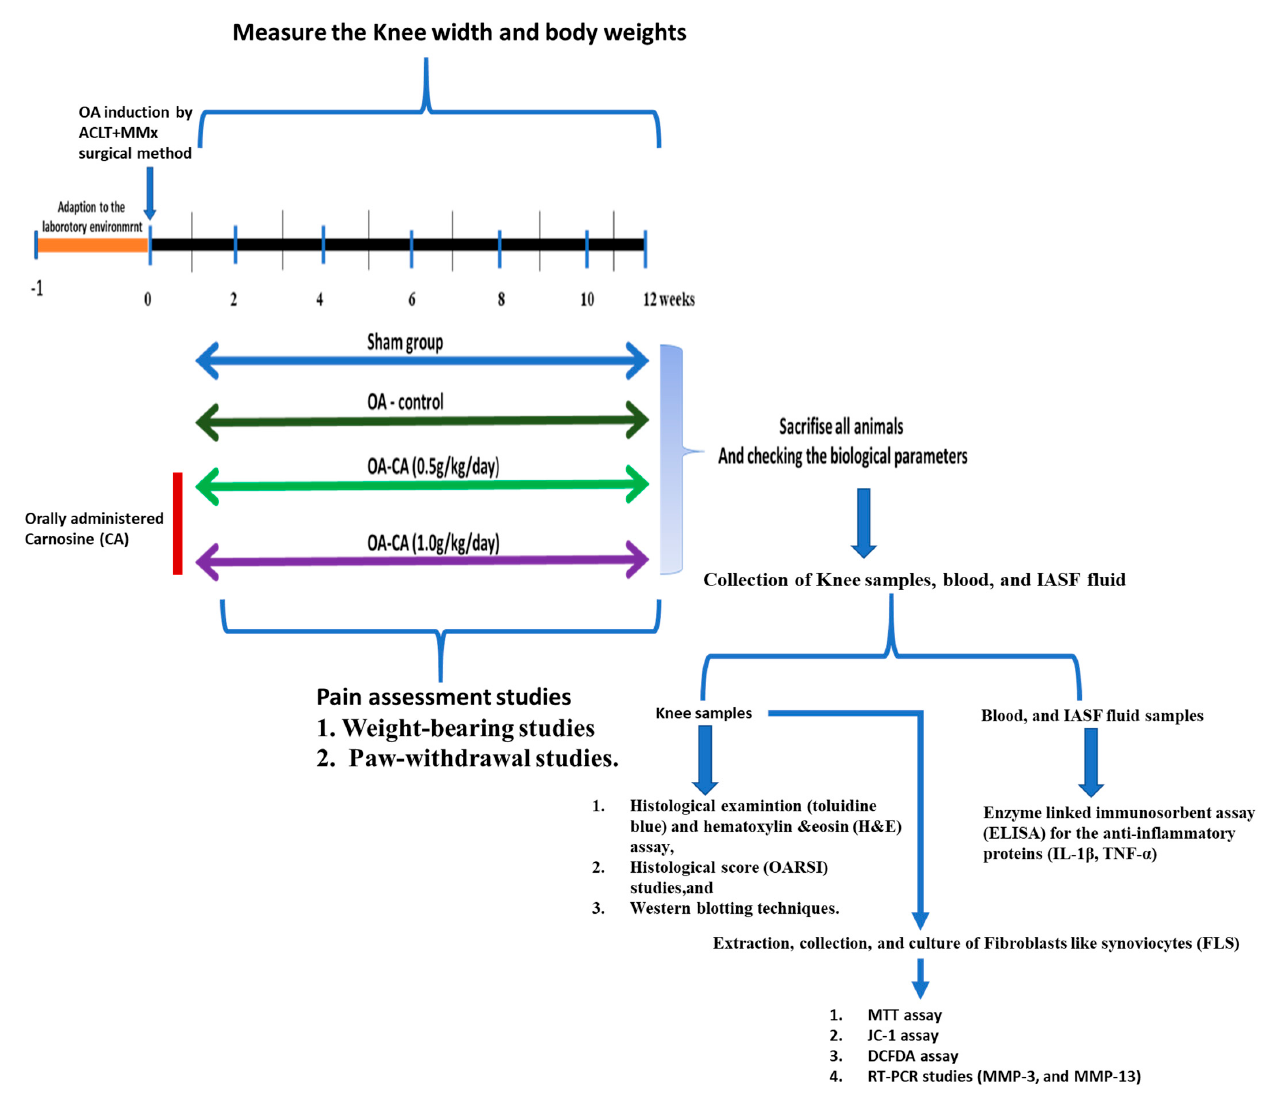
Figure 1. Photographic representation of the experimental design, treatment plan, and collection of knees, blood, and IASF samples for inspection of different parameters.